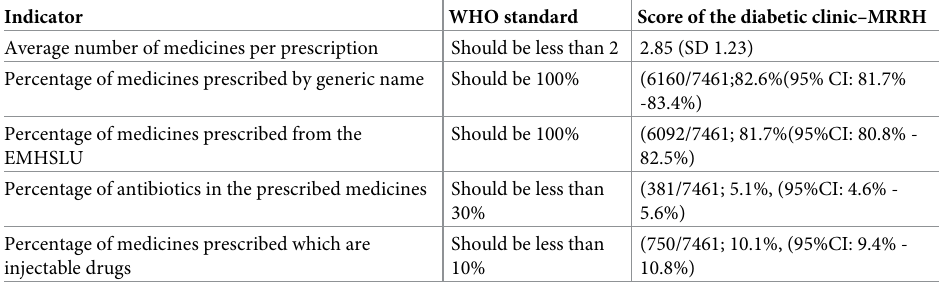
Table 3. Performance of the facility as regards the WHO/INRUD indicators of rational drug use. Indicator WHO